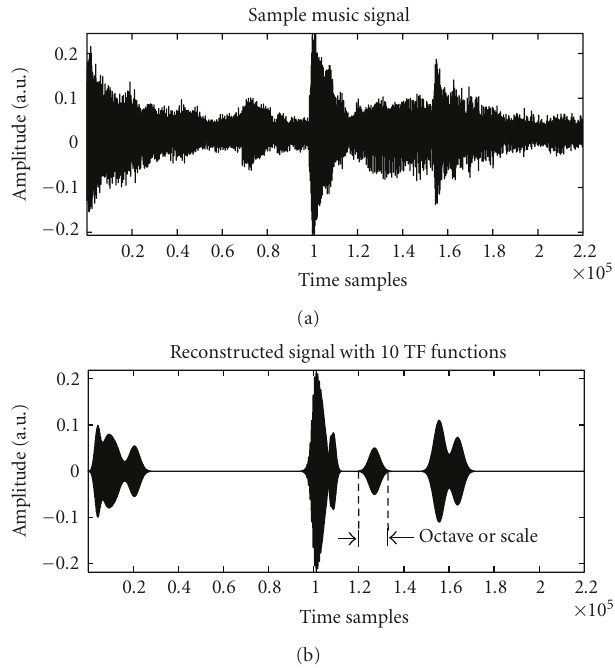
Figure 8: A sample music signal, and its reconstructed version with 10TF